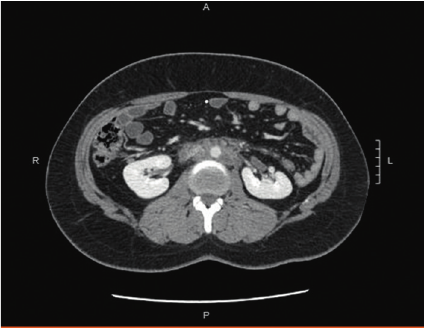
Figure 3: CTimaging of the abdomen and pelvis performed at four weeks shows improvement in retroperitoneal mass appearance.